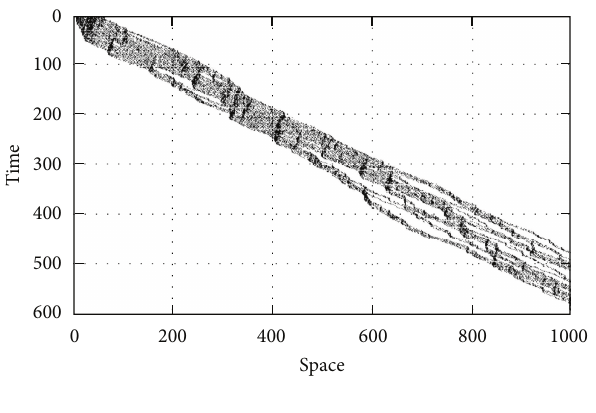
Figure 5: The space-time diagram obtained from the model with 𝑁 = 30 , 𝑃 = 0.31 .